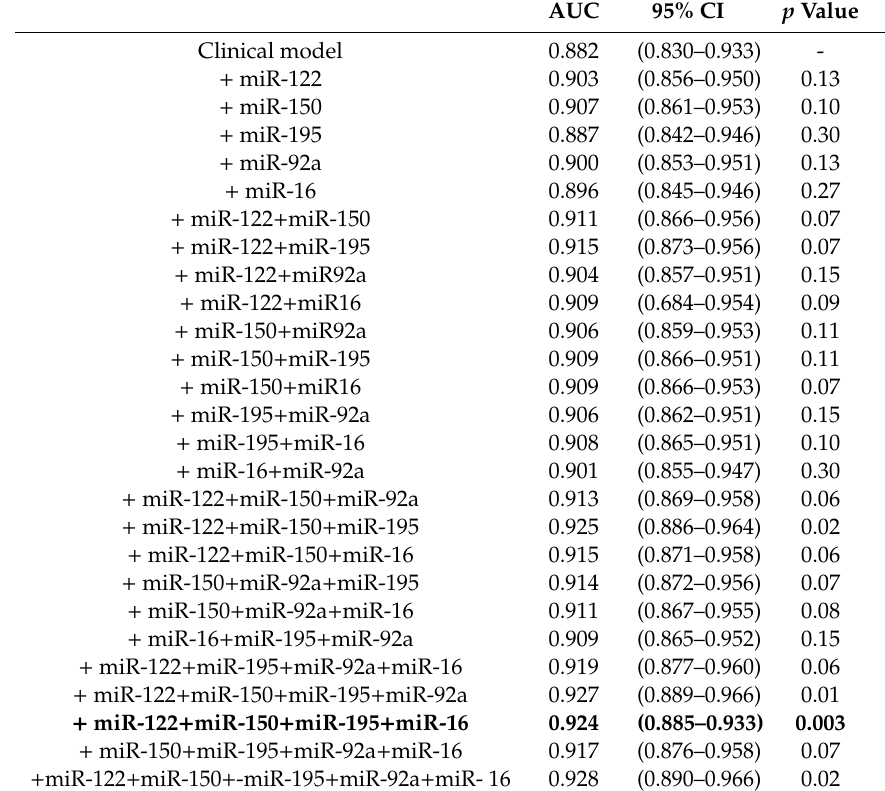
Table 4. Receiver operating characteristic (ROC) curve analysis comparing the predictive value of the basic clinical model with the selected circulating miRNAs added individually or in